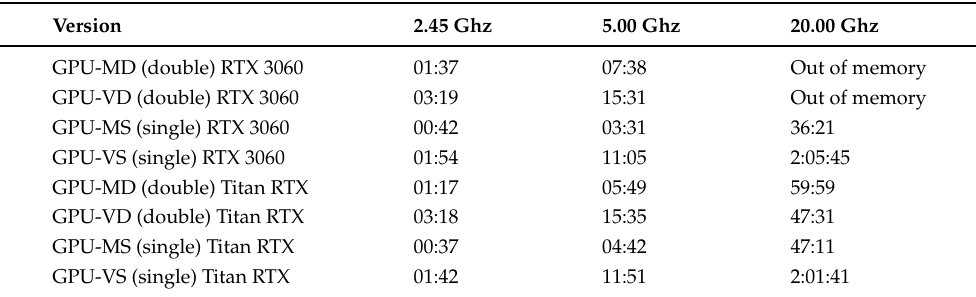
Table 12. Execution times obtained using the RTX 3060 and Titan RTX, expressed in hh:mm:ss, for the parabolic propagation.